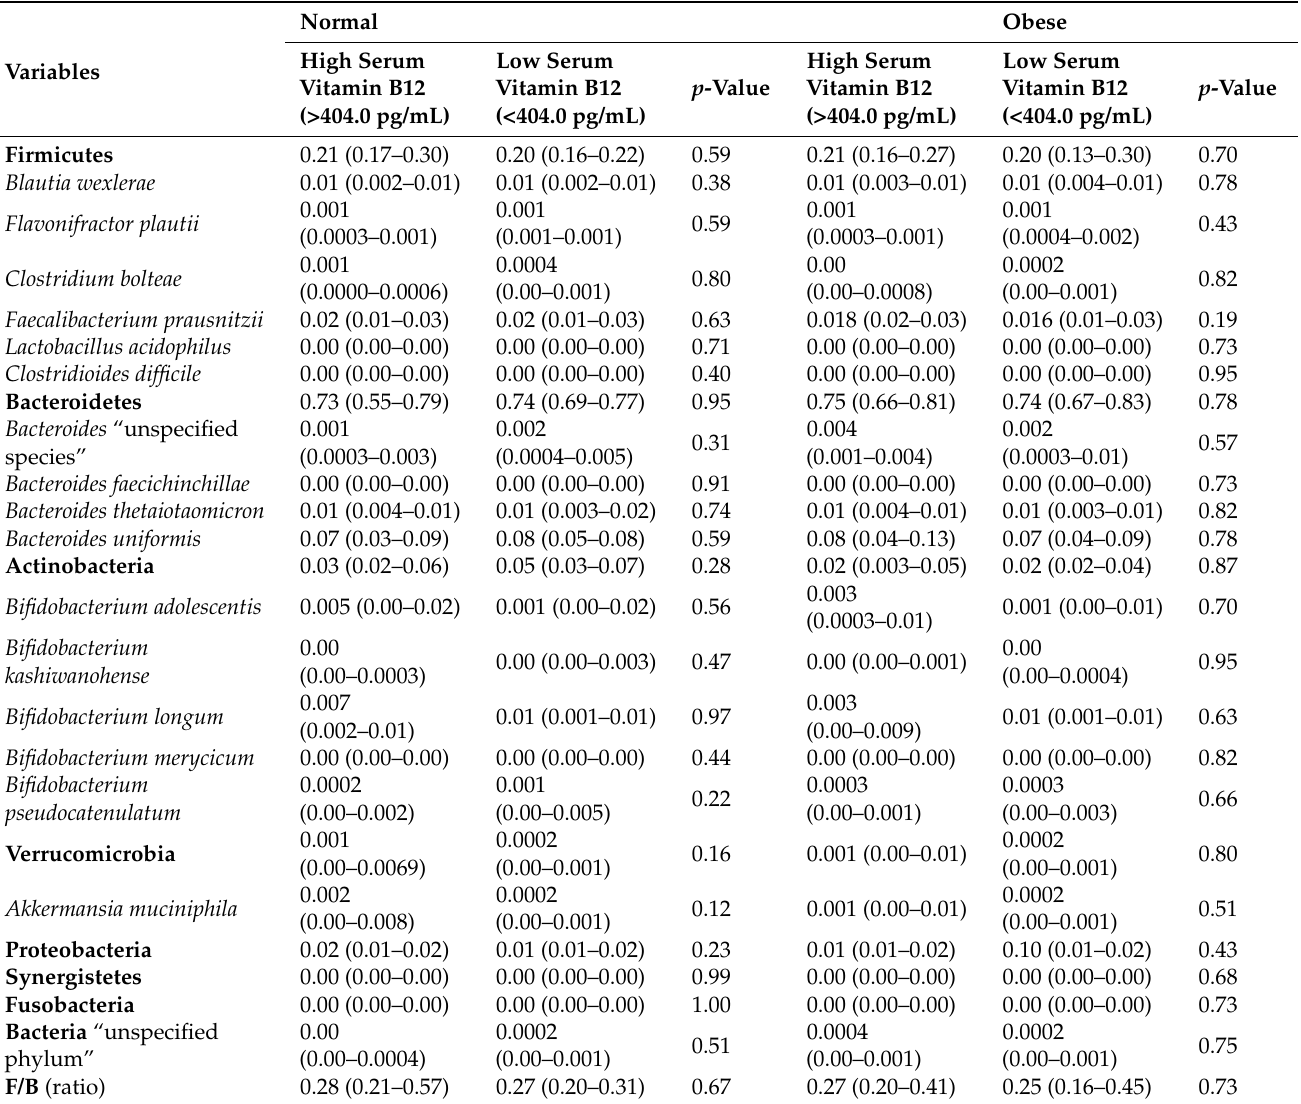
Table 2. Gut microbiota composition by serum vitamin B12 levels among normal-weight and obese participants, n =